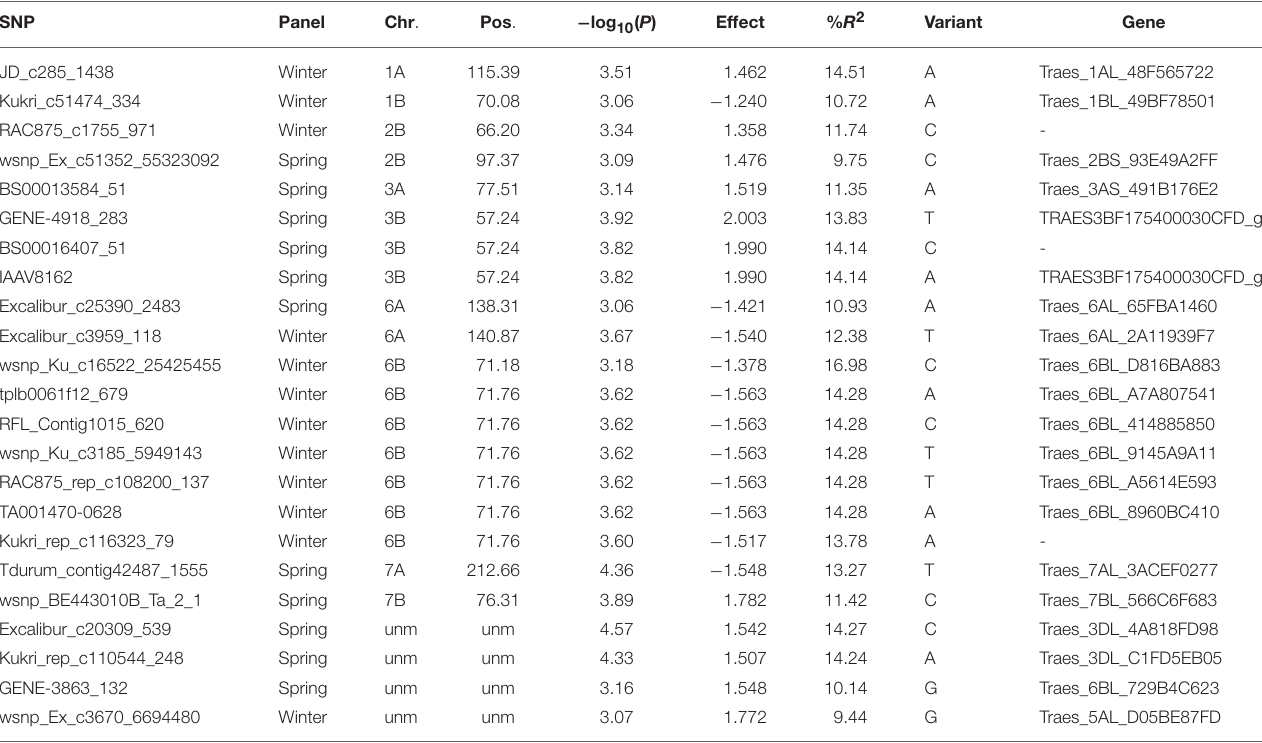
TABLE 1 | List of significant markers ( − log 10 ( P ) > 3.0) for anther extrusion in spring and winter wheat panels based on their BLUEs values. SNP